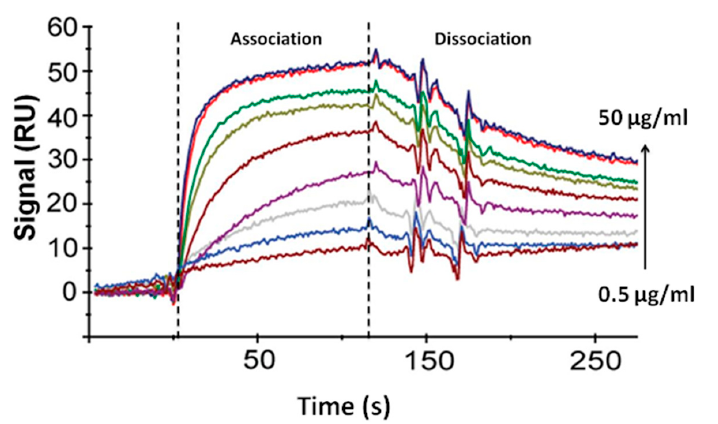
Figure 5. Sensograms of the interaction of the Rv0934 antigen with the surface of the CM5 chip modi- fied with the HTM81 antibodies. Antigen concentration 0.5; 1; 3; 5; 10; 20; 30; 40; and 50 μ g/mL. Dotted lines show the beginning and end of the time interval for the flow of antigen solutions through the sensor cell. The signal is the difference between RU values in the analytical cell and the compari- son cell.